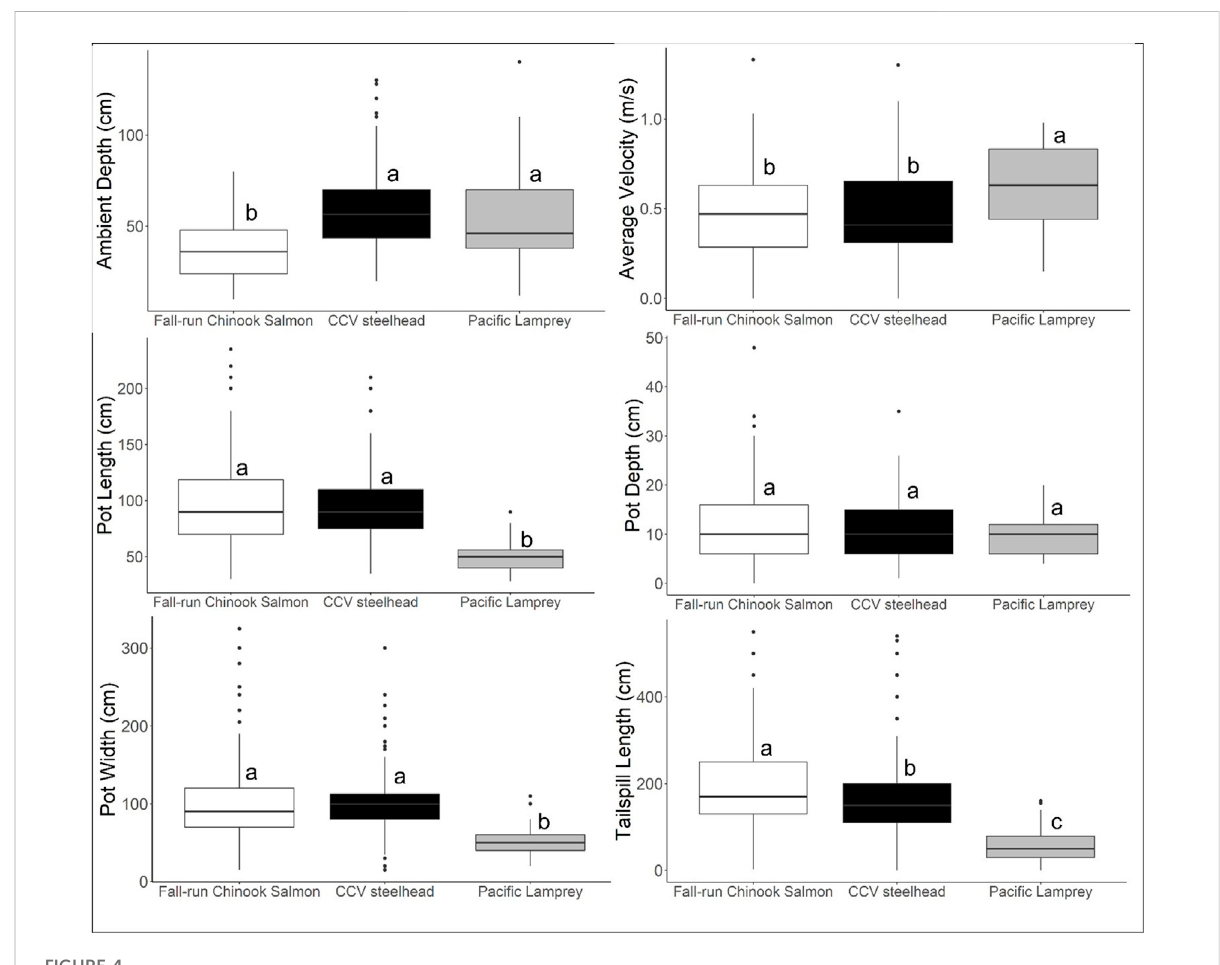
FIGURE 4 ComparisonacrossspeciesofreddmetricsusedfordevelopingDFA.Withineachreddmetric,boxplotswithdifferentlettersindicatesigni fi cant pairwise differences using a Tukey post-hoc test, using a signi fi cance threshold of p = 0.01.